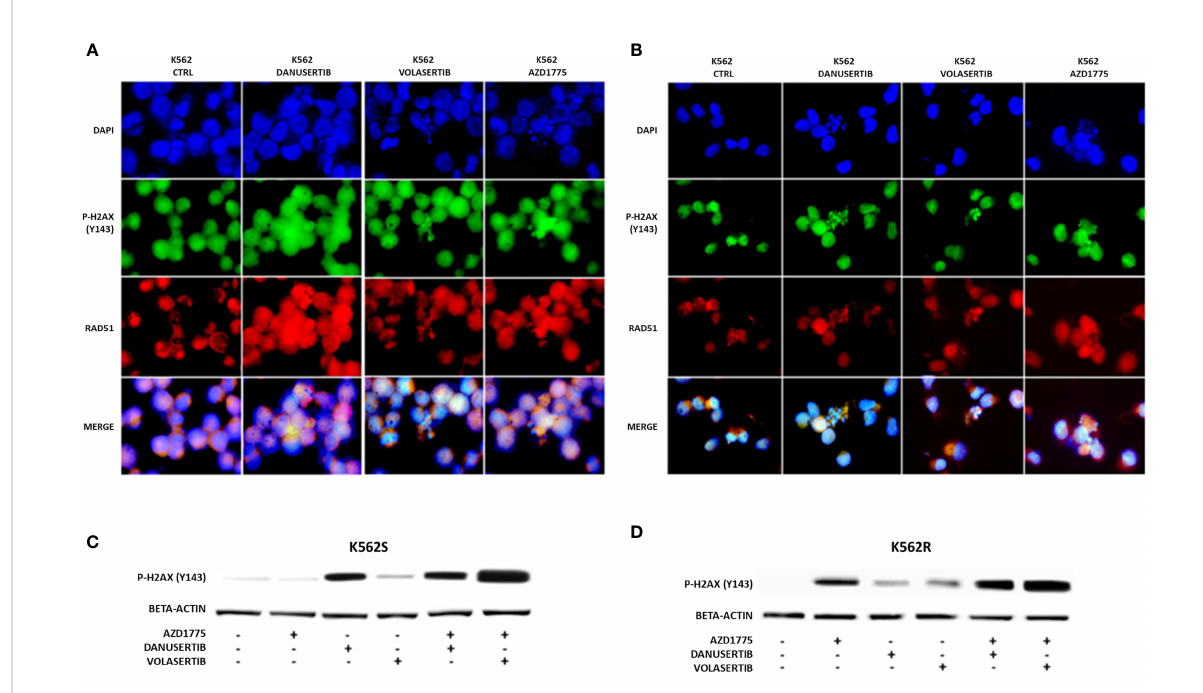
FIGURE 4 Effects of Aurora kinase A, PLK1 and WEE1 inhibition on DNA damage. Panels (A, B) show immuno fl uorescence analysis of phosphorylated histone 2A.X ( ɤ H2AX, green) and Rad51 (red) in K562S (A) compared to K562R (B) after 24 hours of treatment with danusertib, volasertib and AZD1775. The K562R cell line is cultured maintaining a constant imatinib concentration in the medium. Staining with DAPI (4 ’ ,6-Diamidino-2- Phenylindole) indicates the nuclear localization of ɤ H2AX and RAD51. Panels (C, D) show Western blotting analysis of phosphorylated histone 2A.X revealing the effects on DNA damaged cells of danusertib or volasertib alone as compared to 24h priming with danusertib or volasertib alone + 24h combination of danusertib or volasertib+AZD1775. K562R cells were maintained in RPMI additioned with 10 µM imatinib. Beta-actin was used as loading control. Western blotting assays were performed starting from lysates obtained from three independent drug treatments